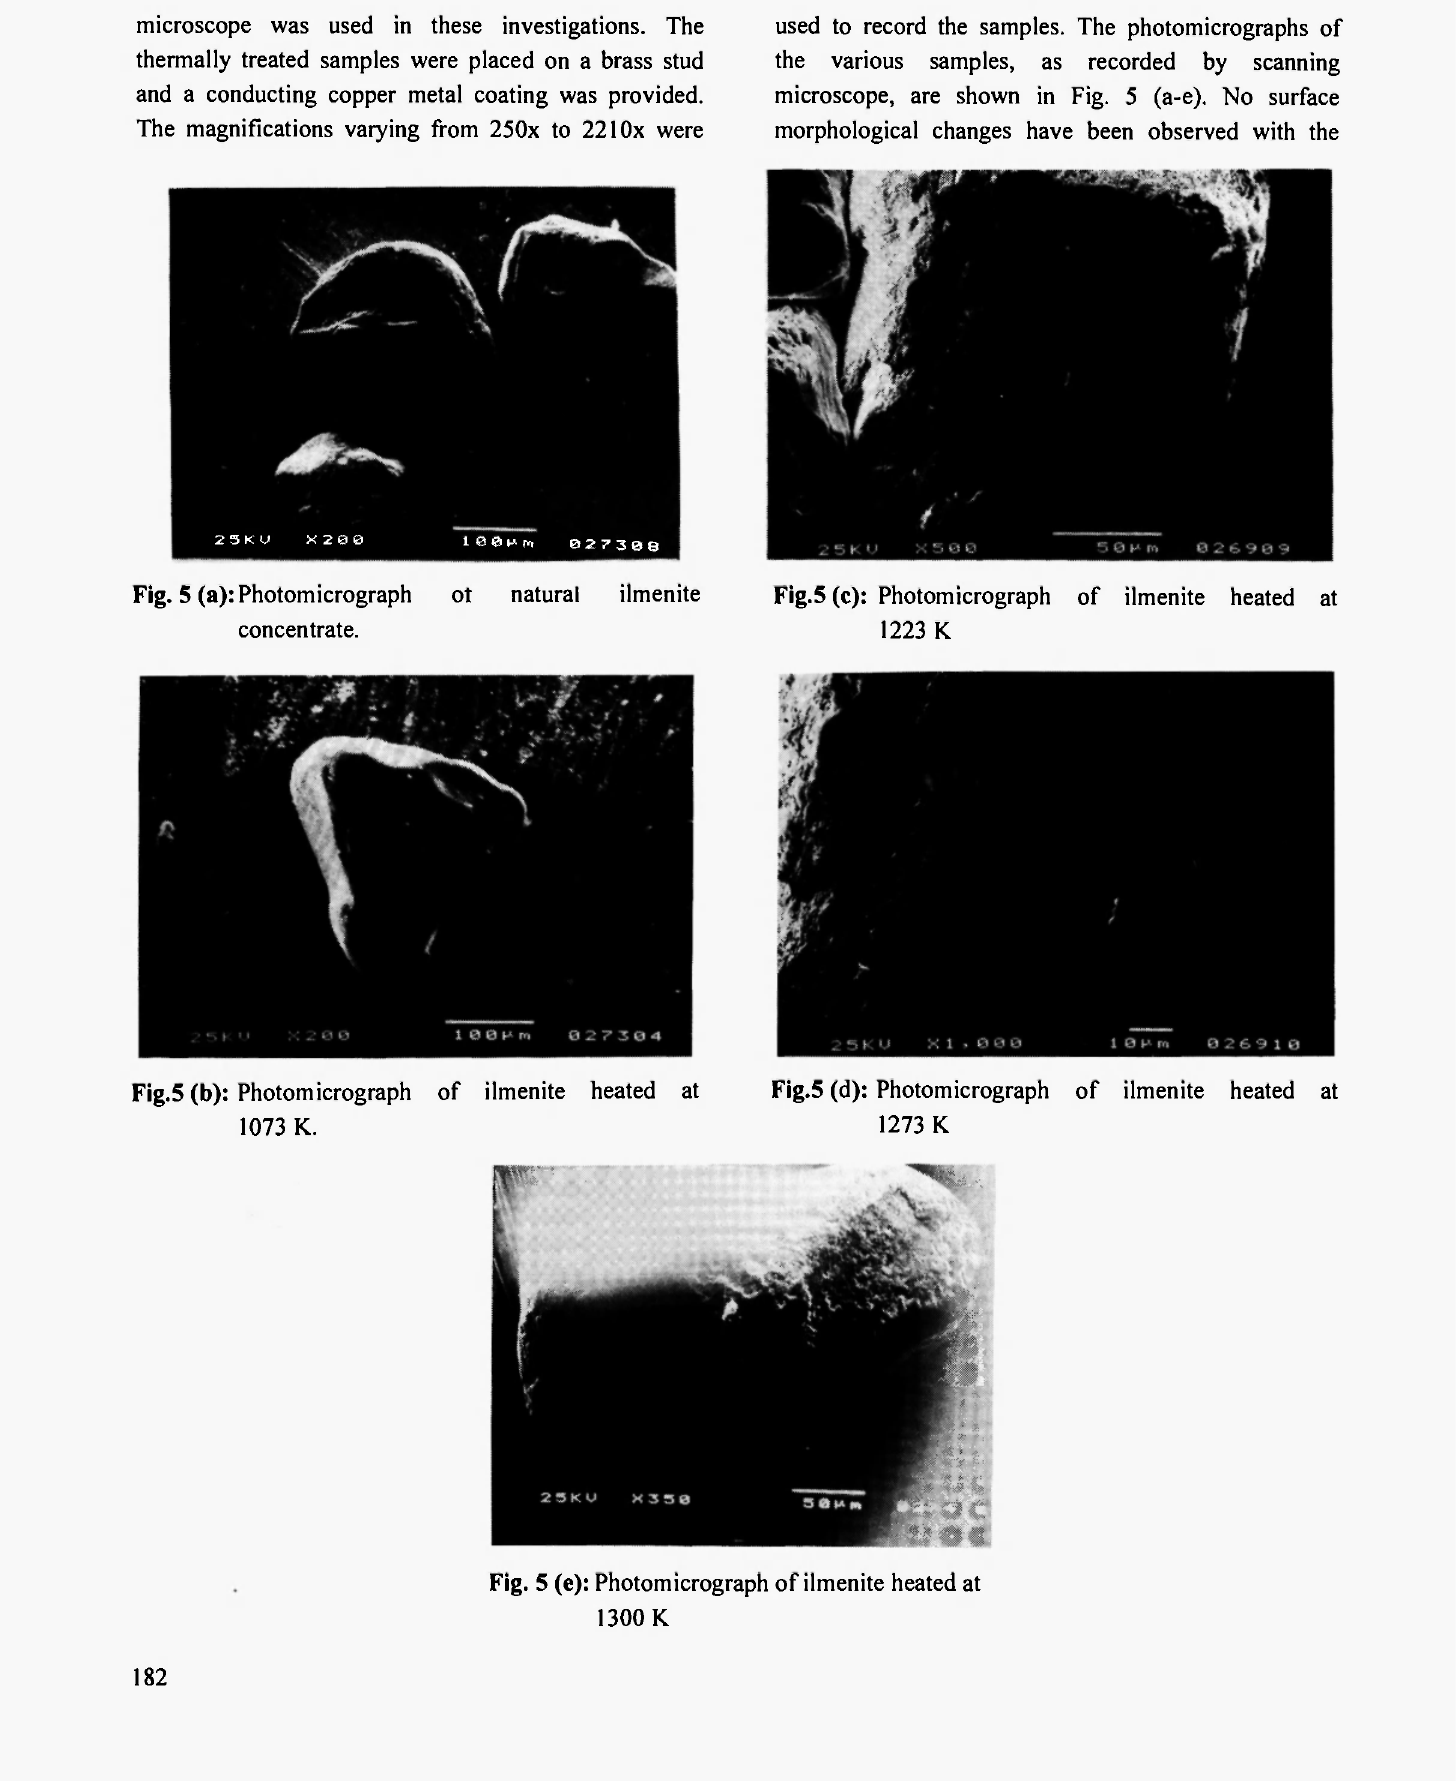
Fig. 5 (e): Photomicrograph of ilmenite heated